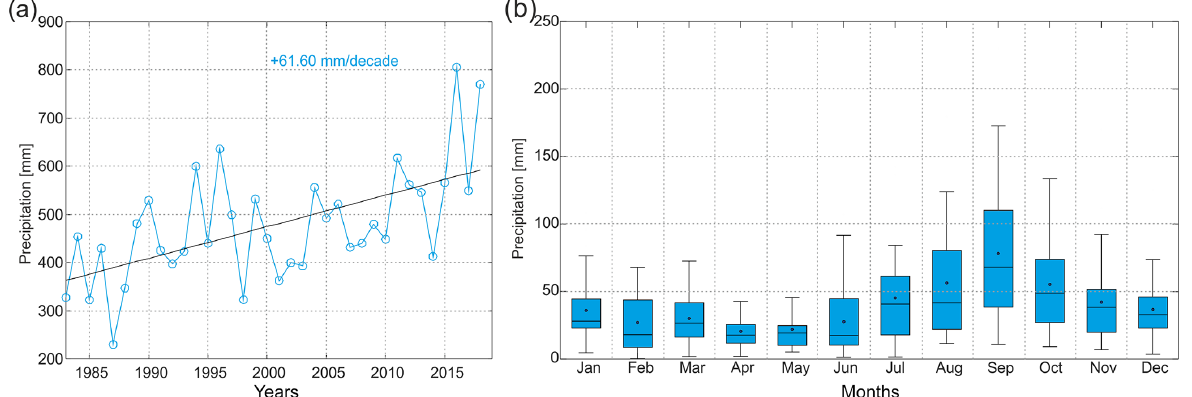
Figure 4. (a) Variability of annual sums of precipitation in 1983–2018 at Hornsund. (b) Variability of mean monthly sums of precipitation in 1983–2018 at